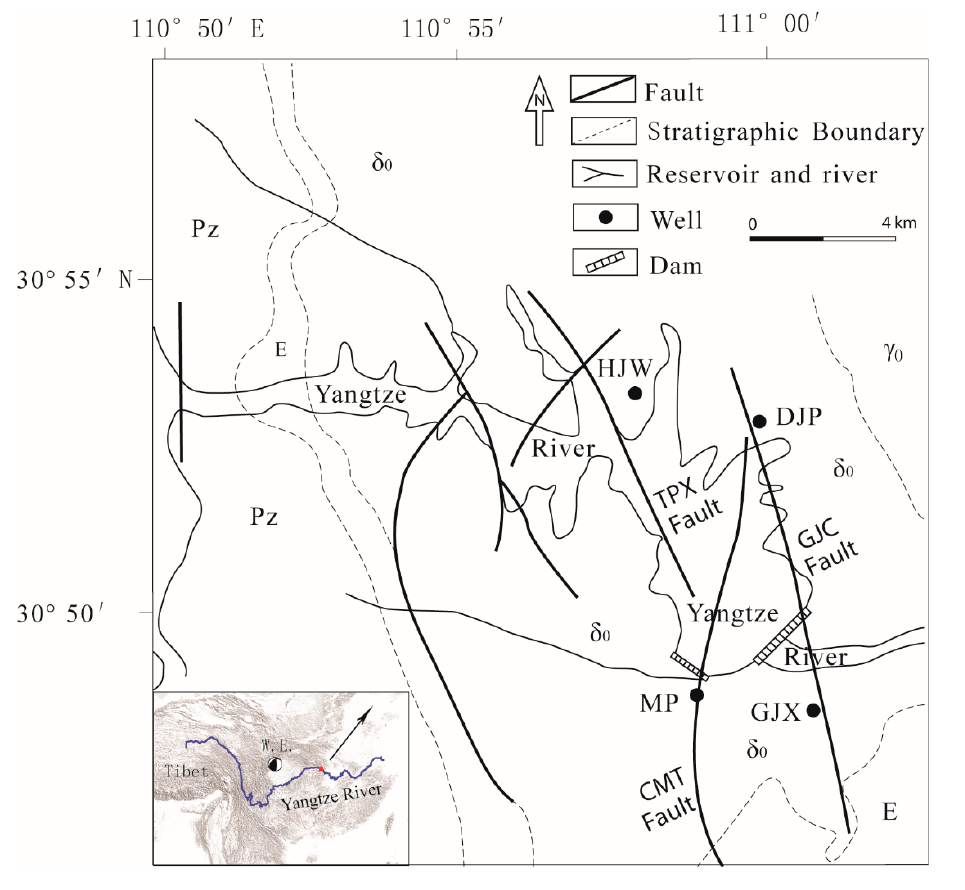
Figure 1. Geological setting and location of the four wells around the Three Gorges Dam. The inset is an enlargement of the study area. The abbreviation W.E. in the inset represents the Wenchuan earthquake. The figure was adapted from Zhang et al.